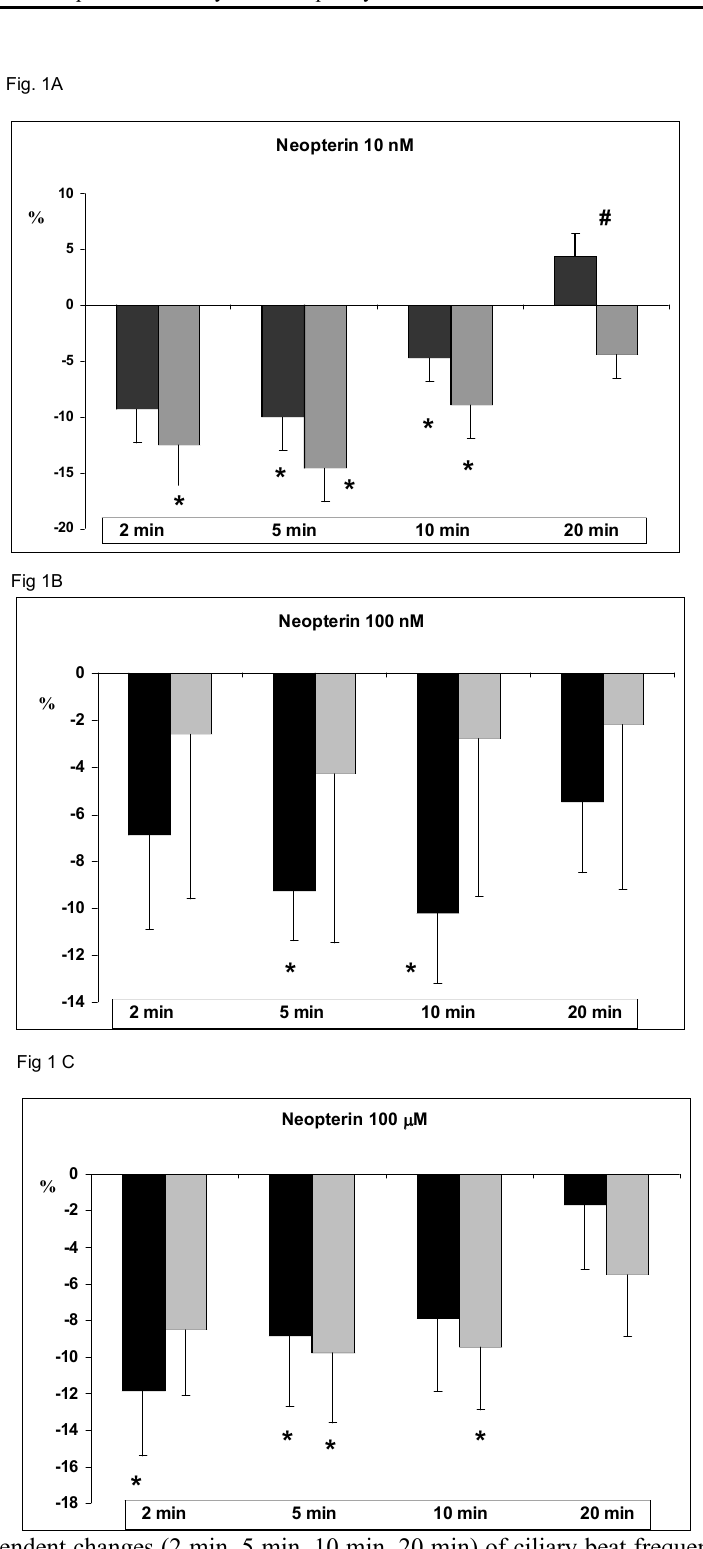
Figure 1: Time dependent changes (2 min, 5 min, 10 min, 20 min) of ciliary beat frequency after incubation of human nasal ciliary cells with neopterin (10 nM, fig 1A, 100 nM, fig. 1B and 100 µ M, fig 1C) either in aqua des- tillata (black bars) or sodium chloride 0.9% (grey bars). Data were calculated as percentual changes between test substances and baseline. Results are given as mean values ± SEM. Asterisks indicate p < 0.05 (*) as compared to baseline data without test substances or indicate p < 0.05 ( # ) between the corresponding time points of neopterin either solved in aqua or in NaCl (Wilcoxon